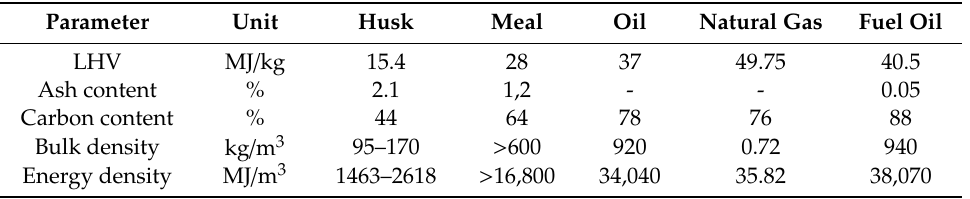
Table 1. Properties of selected fuels.